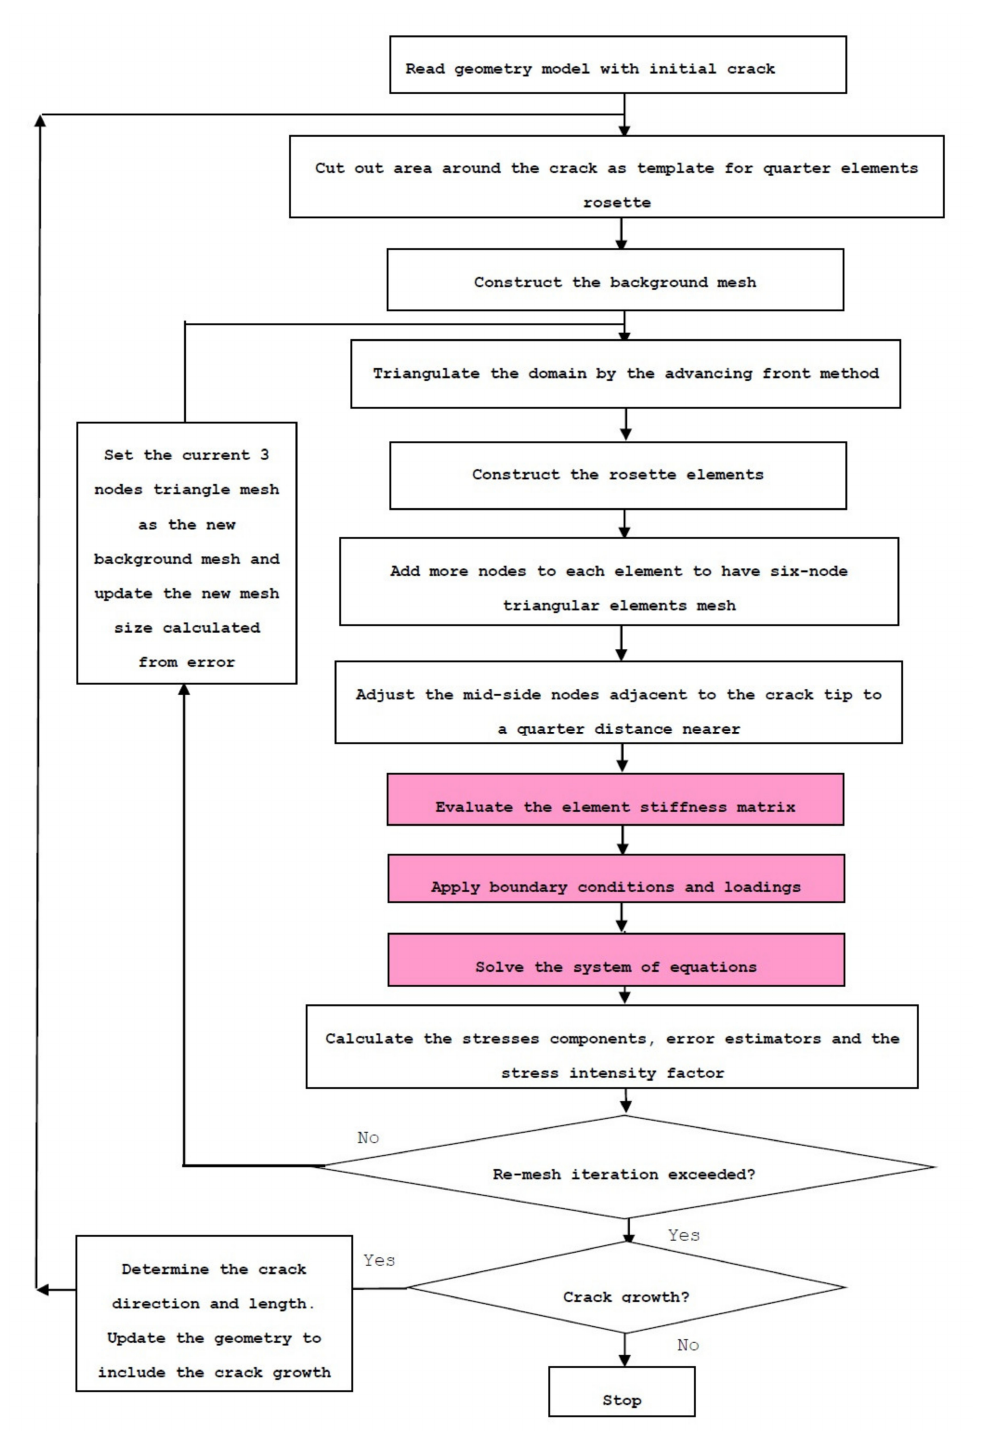
Figure 1. Computational scheme of the Fatigue Crack Propagation